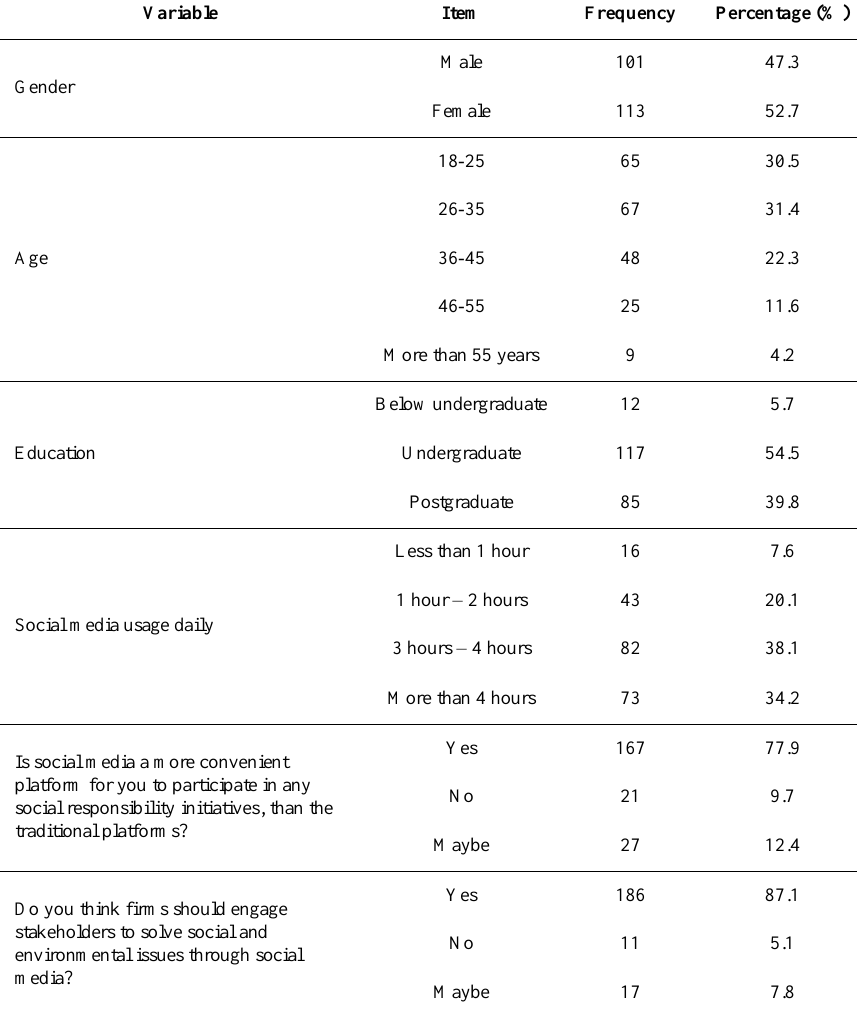
Table 2. Questionnaire respondent